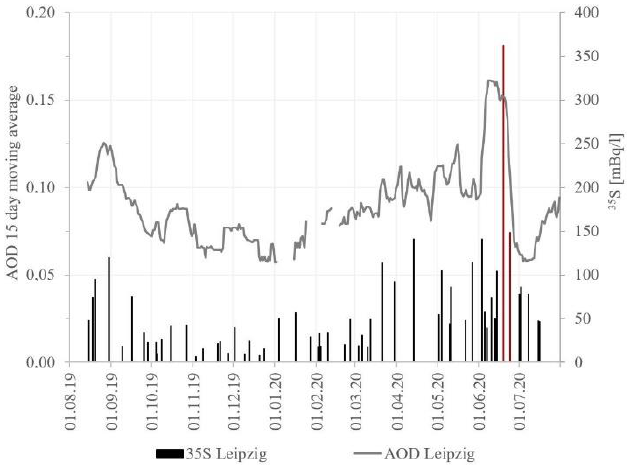
Figure 5. Complete time series 35 S and AOD (at wave lengths 1640 and 1020 nm).